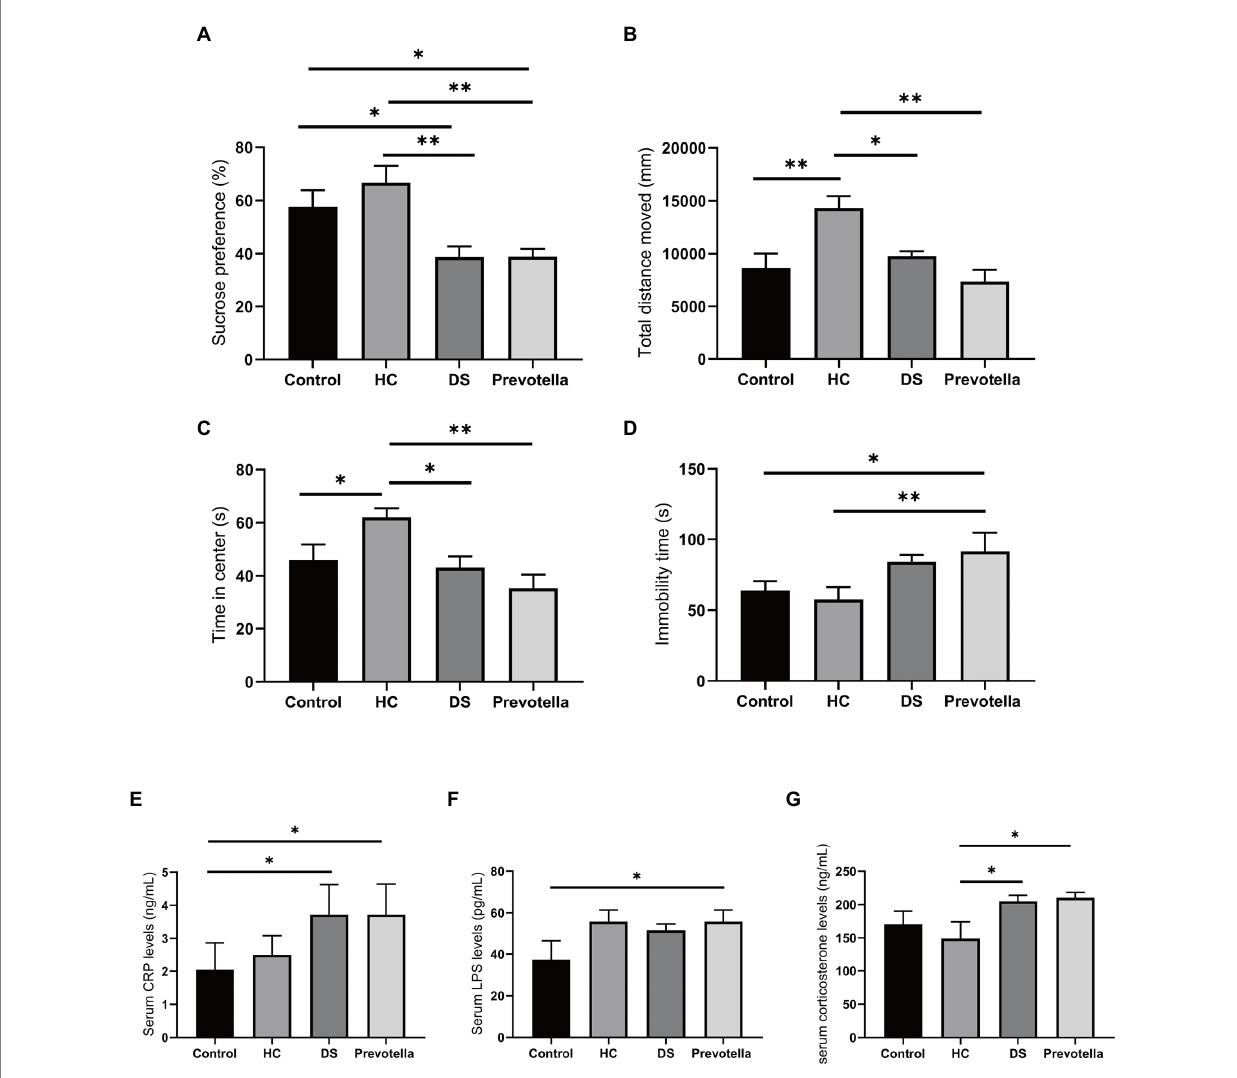
FIGURE 7 Behavioral effects of intestinal microbiota derived from non-DS volunteers or individuals with DS and Prevotella copri in germ-free mice. (A–D) Behavior of mice treated with intestinal microbiota derived from non-DS volunteers or individuals with DS and Prevotella copri in sucrose preference, open field, and forced swimming tests. Mice treated with intestinal microbiota derived from individuals with DS or Prevotella copri exhibited reduced sucrose preference (A) , reduced total distance traveled (open field test) (B) , reduced time in center (open field test) (C) , and increased immobility time (forced swimming test) (D) . (E–G) Effects of intestinal microbiota derived from non-DS volunteers or individuals with DS and Prevotella copri on serum CRP (A) , LPS (B) , and corticosterone (C) levels. Each group contained 6 mice. The data are expressed as the mean ± SEM from one-way ANOVA followed by a post hoc test and Student’s t -test. * p < 0.05, and ** p <